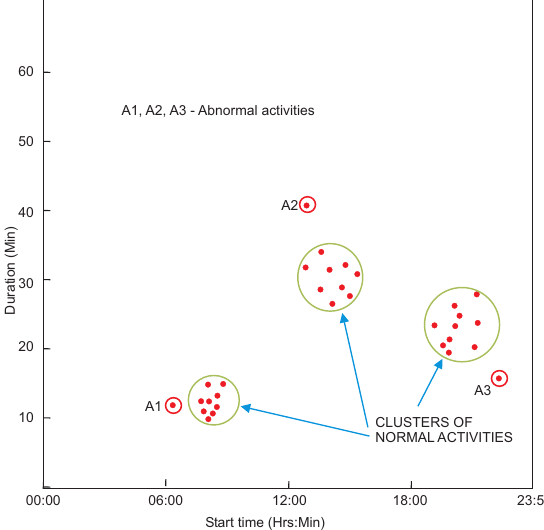
Figure 3. An example of defining normal eating habits and finding deviating behaviors by clustering a bidimensional dataset (start time and duration of meals). Abnormal activities A1, A2, A3 are outliers with respect to the clusters.